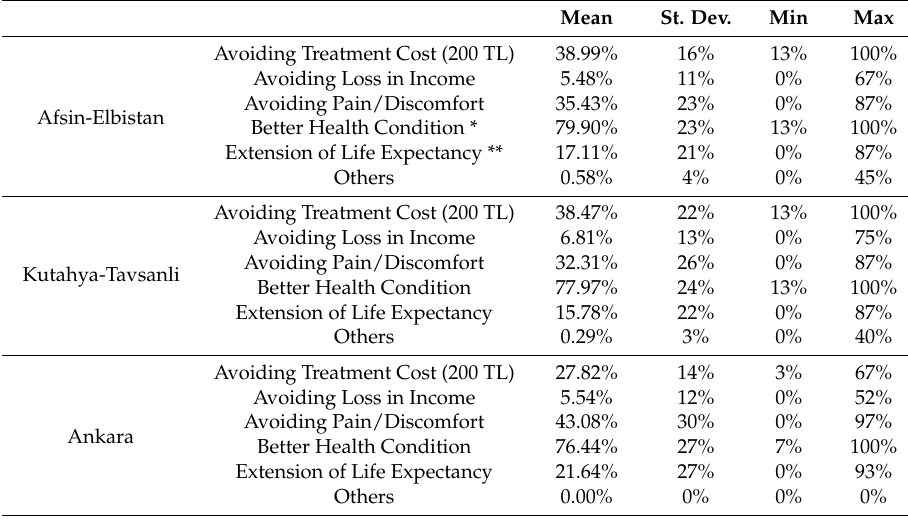
Table 3. The Allocation of WTP for different